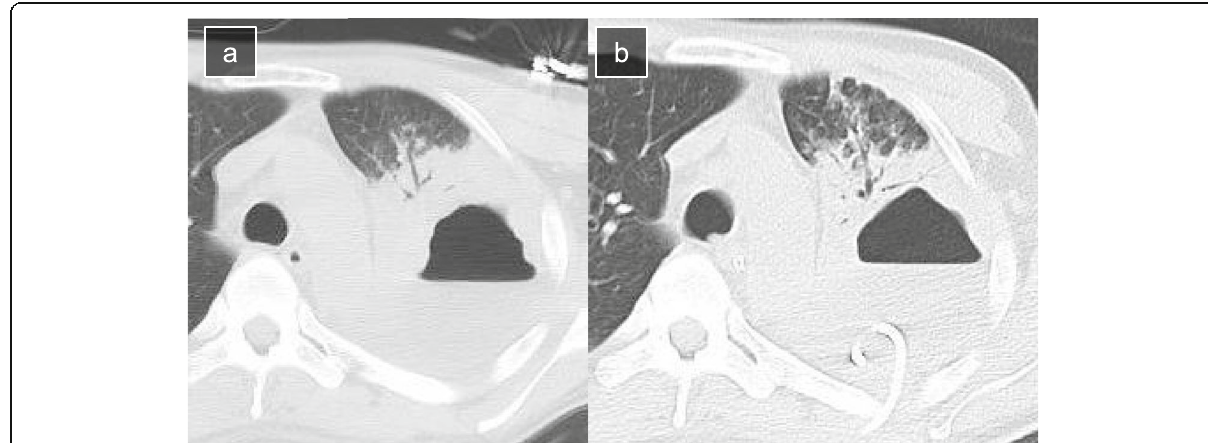
Fig. 1 Computed tomography findings before and after initial percutaneous drainage. a A large abscess with an air-fluid level in the left upper